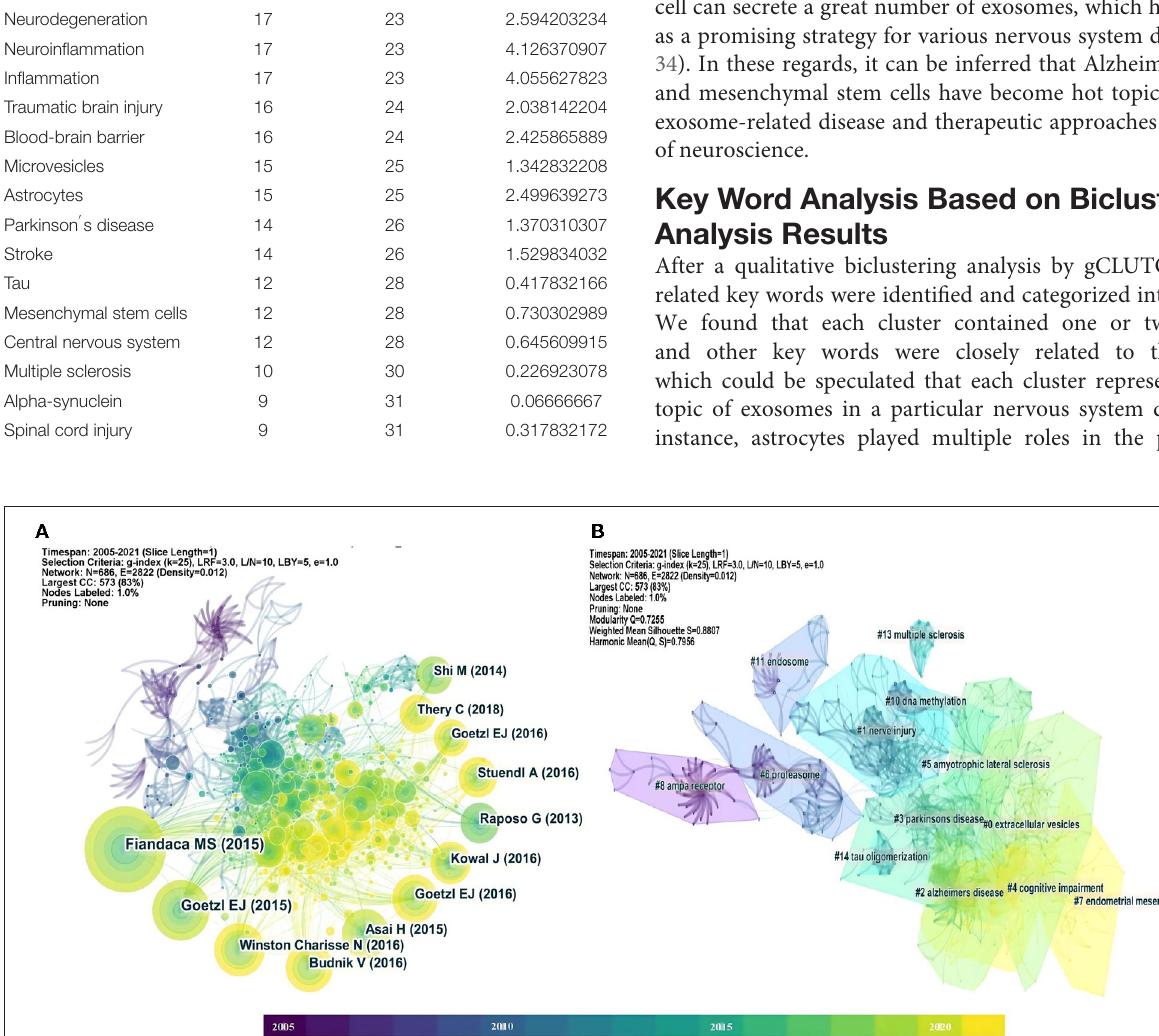
Frontiers in Neurology |